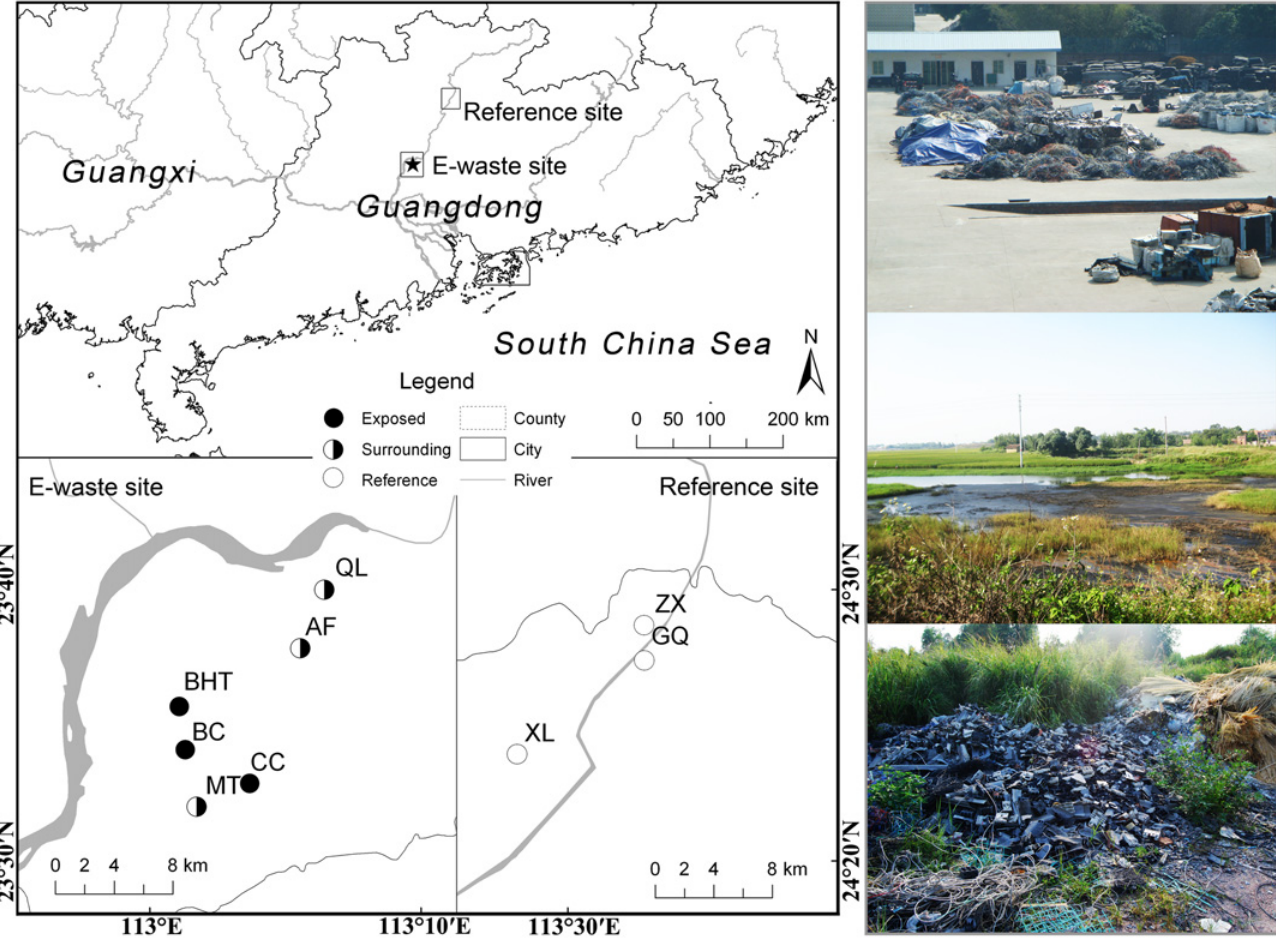
Fig 1. Location of the e-waste exposed, e-waste surrounding and natural reference sites where bird population densities were measured in Guangdong, China. Study sites are coded by different treatments as black circles (exposed, i.e. BHT-Baihetang, CC-Changchong, BC-Banchong), white and black circles (surrounding, i.e. MT-Matou, QL-Qinglian, AF-Anfeng), and white circles (natural, i.e. ZX-Zhouxi, XL-Xinliang, GQ-Gaoqiao). Photo tip: the scene of recycling workshop, polluted river and dumping site in e-waste area.